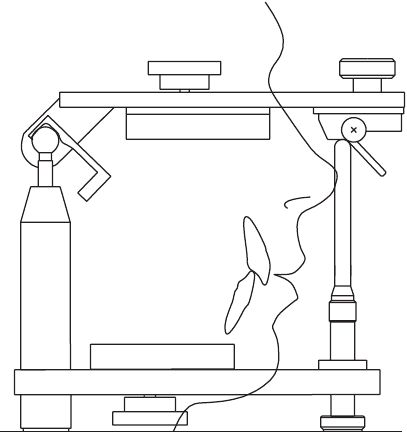
Figure 1: A schematic representation of a dental articulator, as implemented in the interactive editor of the simulation software.